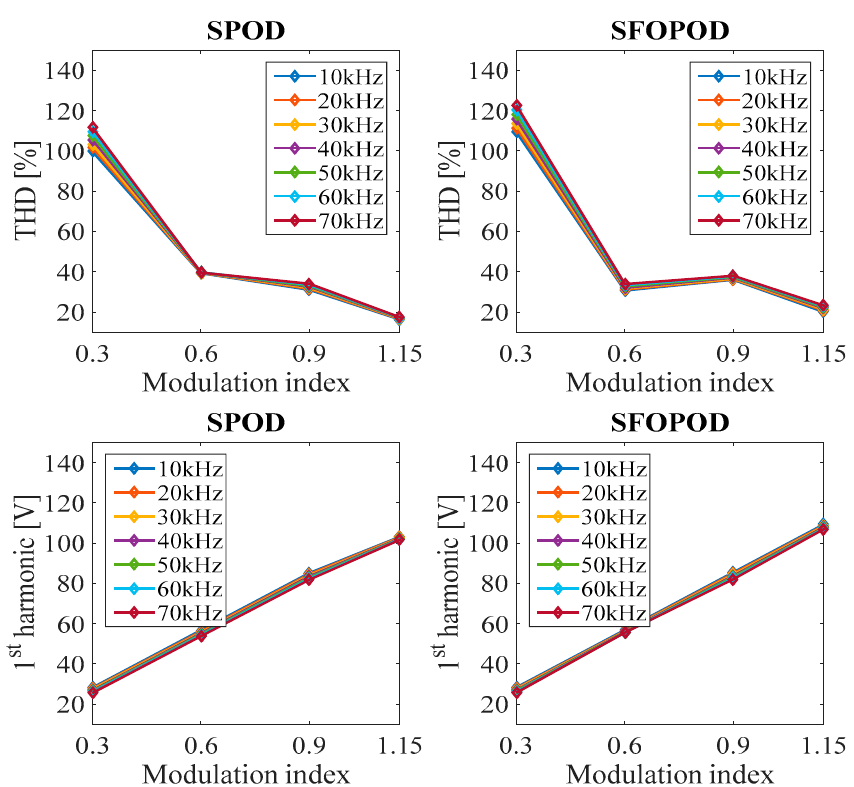
Figure 15. Experimental THD% and fundamental amplitude trends of SPOD and SFOPOD schemes.